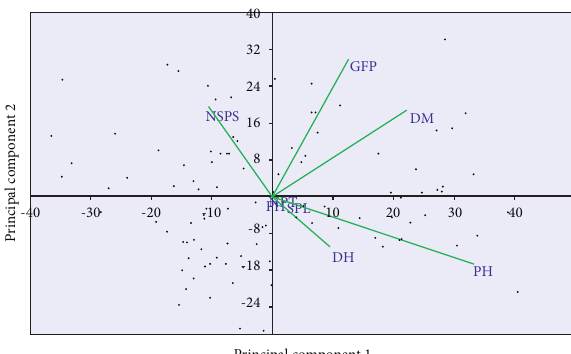
Cumulative percent of total variance explained